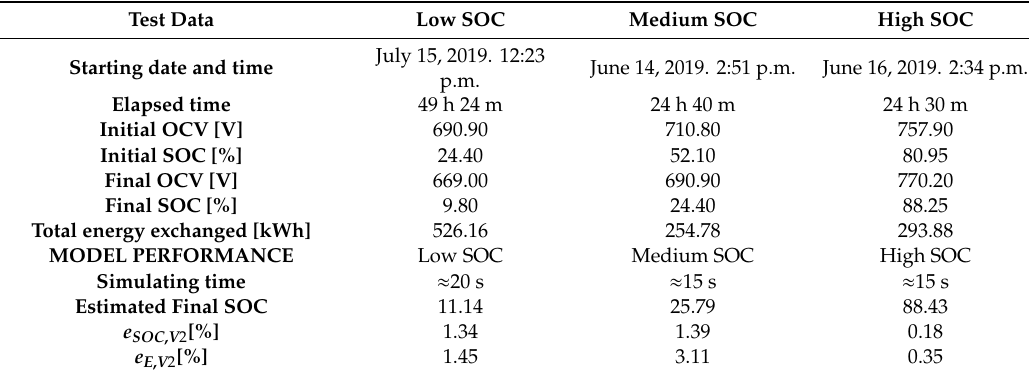
Table 10. Validation tests summary.